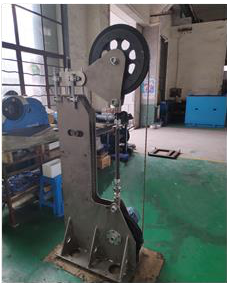
Figure 1. Experimental platform of diamond wire saw cutting.